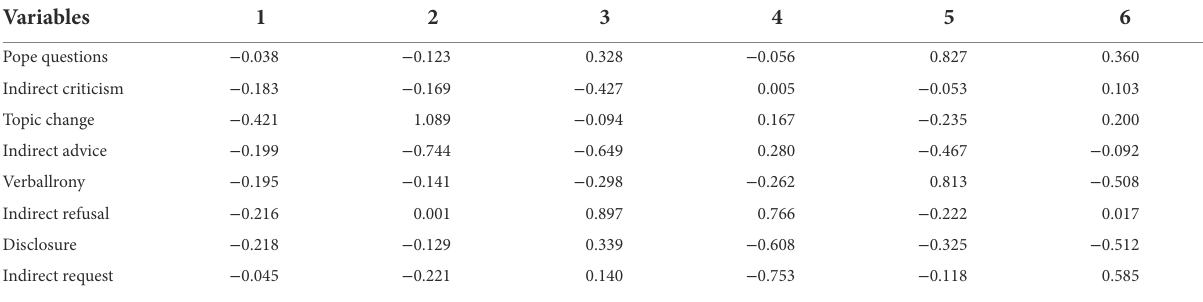
TABLE 10 Canonical coefficients for Set 1.